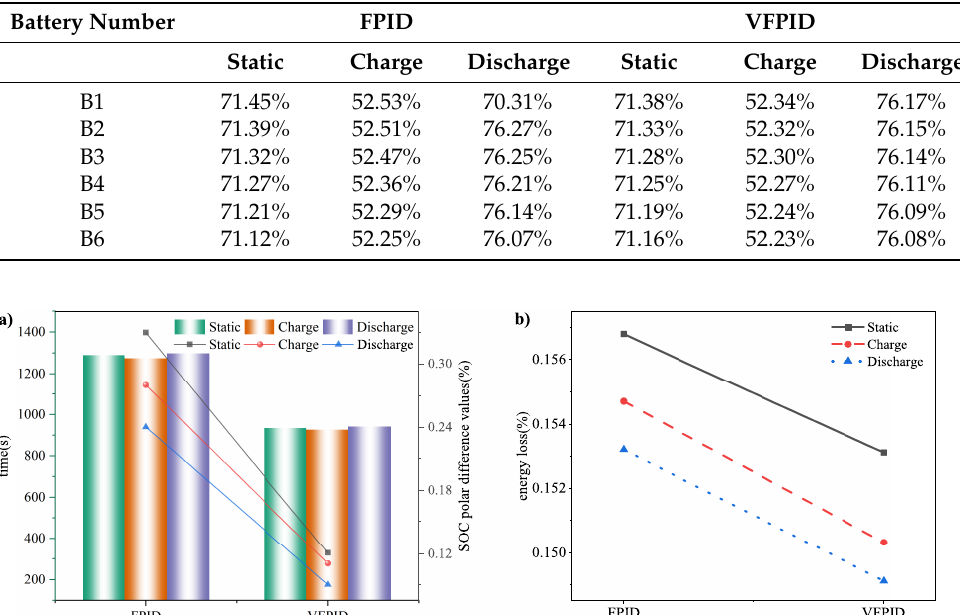
Figure 17. The equalization process of FPID and VFPID in the discharged state: ( a ) FPID; ( b ) VFPID. Table 8. Equalization experimental data.